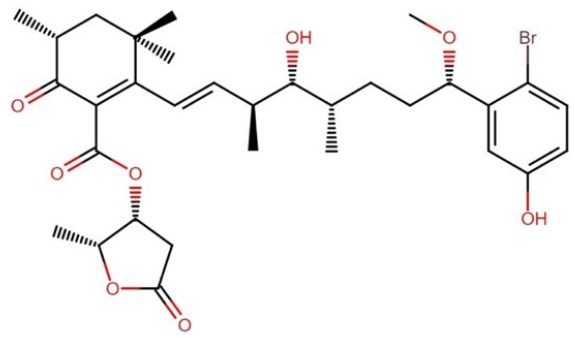
Figure 20. Chemical structure of oscillatoxin I.